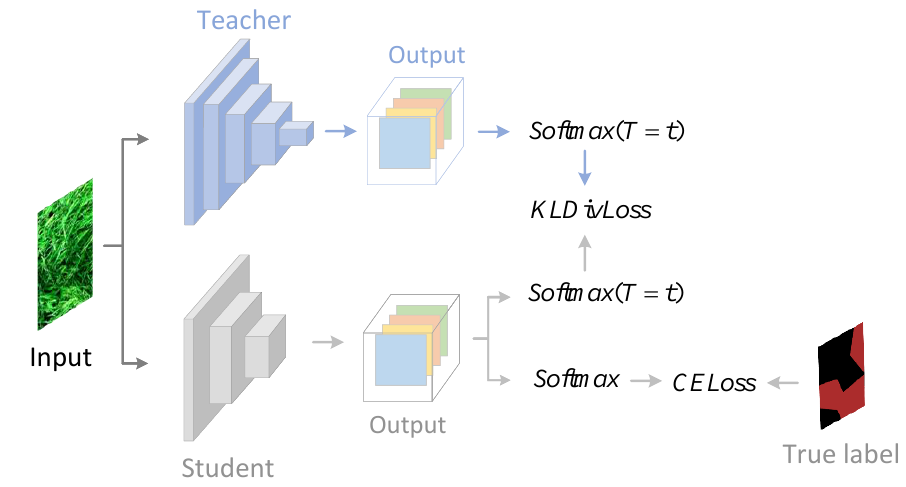
Figure 5. Training the student network with knowledge